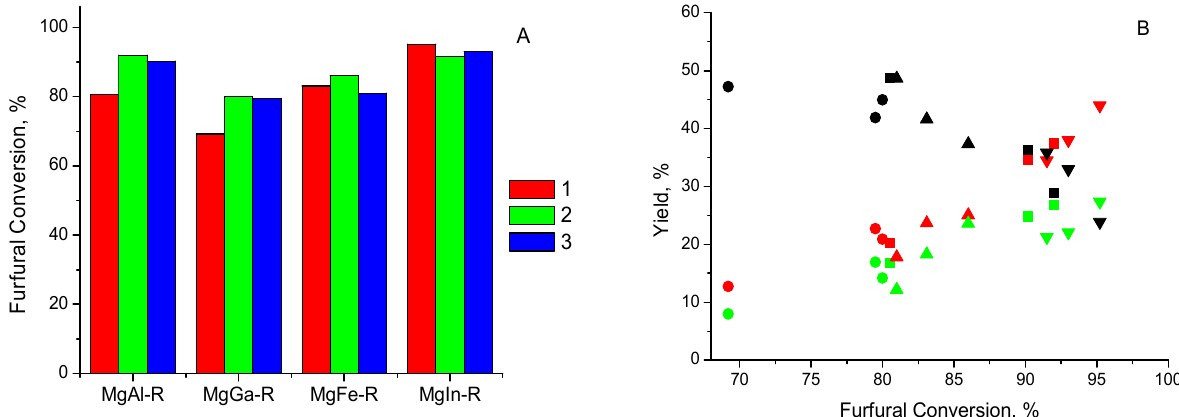
Figure 6. ( A ). Furfural conversion in three consecutive cycles [calcination-rehydration-reaction] in the presence of different MgM-R materials; ( B ) the yield of reaction products observed in three reaction cycles. Black symbols—FAc-OH, red symbols—FAc, green symbols—F 2 Ac; squares—MgAl-R, circles—MgGa-R, triangle up—MgFe-R, triangle down—MgIn-R. Molar ratio furfural: acetone = 5, T reac. = 25 °C, reaction time—3 h.